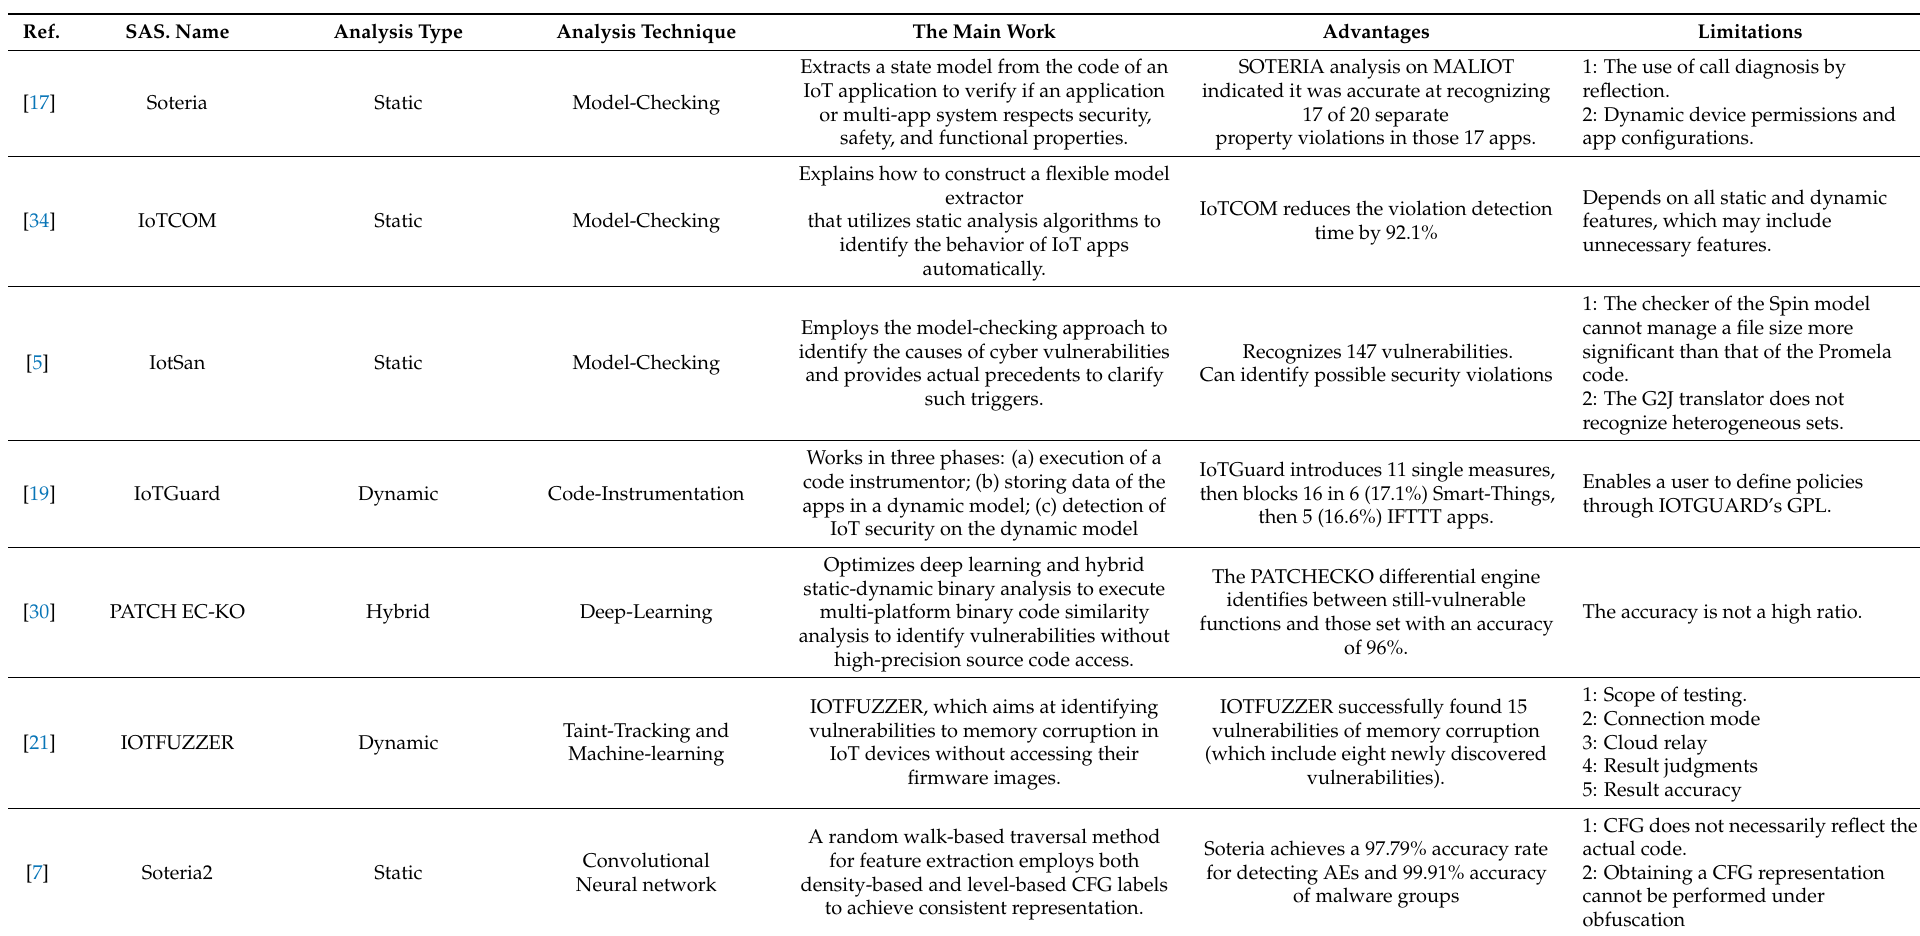
Table 1. An Overview of Security Analysis Systems (SAS) in IoT